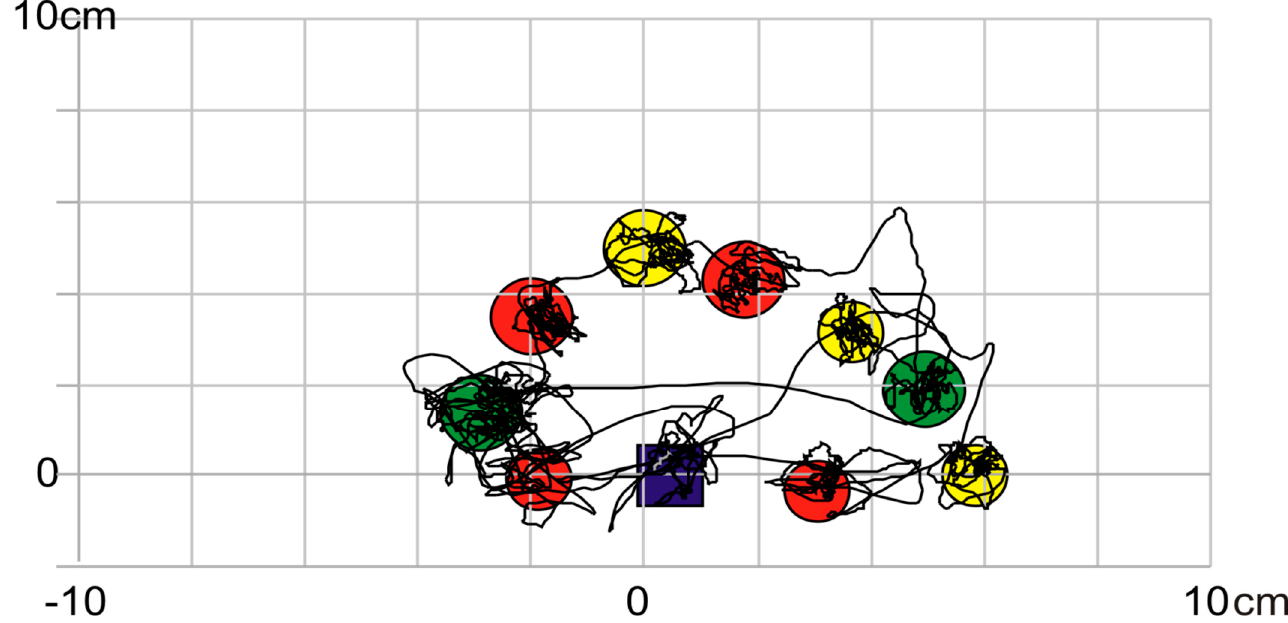
Figure 1. A statokinesiogram: the trajectory of the COP movements on the ground XY plane together with the positions of virtual objects on the screen. Please note that whereas the individual objects appear on the screen sequentially, the above picture shows them all together.